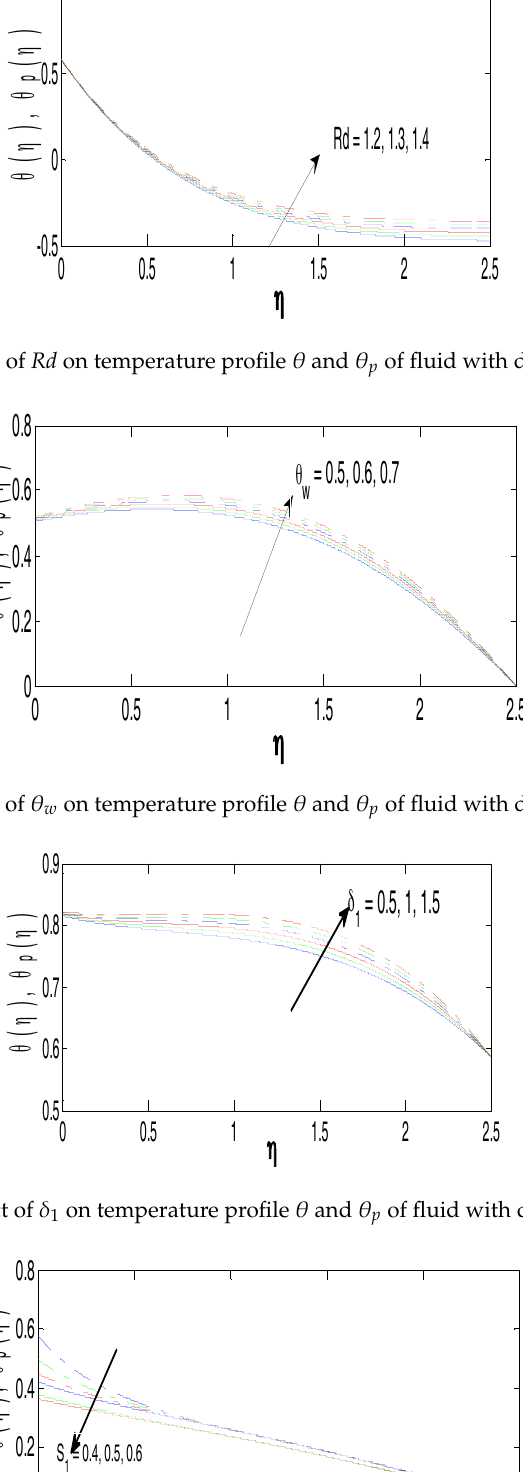
 of fluid with dusty particles. p